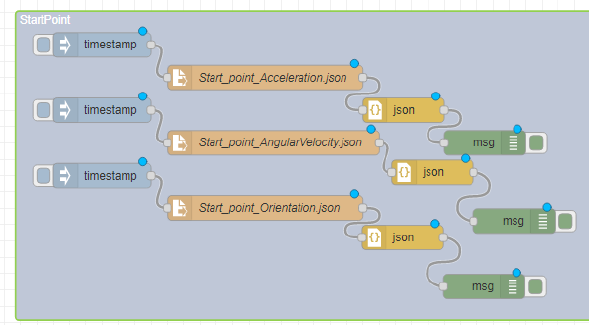
Figure 66. Start point acceleration sensor.